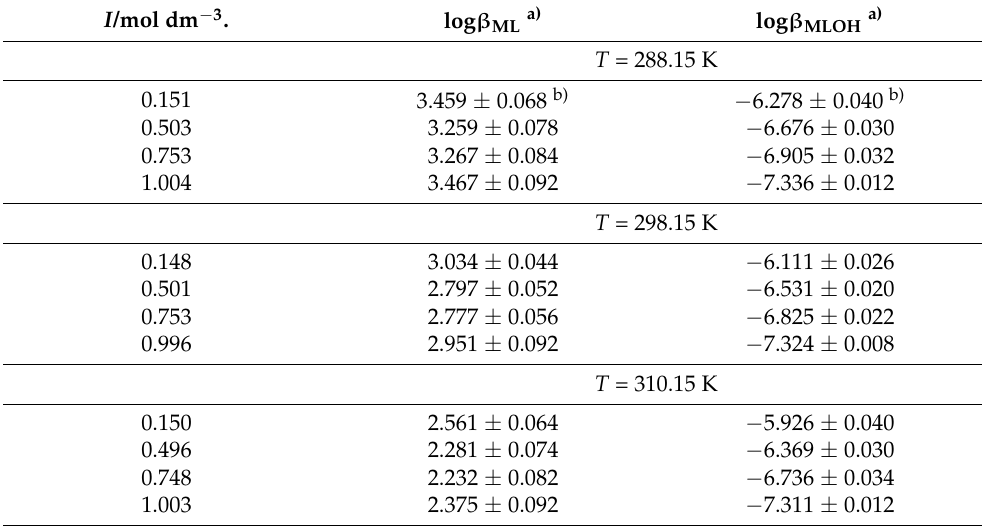
Table 5. Experimental formation constants of the Mg 2+ /Dop − species in NaCl aqueous solutions at different ionic strengths and temperatures. I /mol dm − 3 . log β ML a) log β MLOH a) T = 288.15